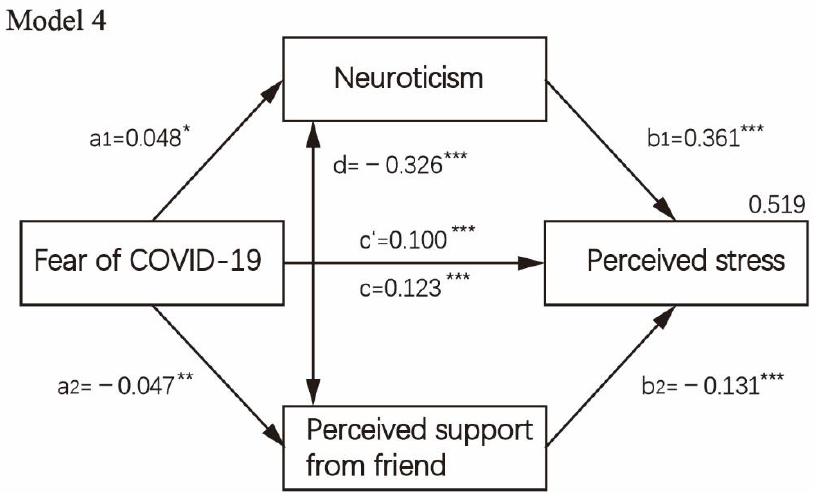
Figure 5. Mediation analysis test on fear of COVID-19 concerning perceived stress and mediating role of neuroticism and subscale of perceived social support from friends and controlling covariates, i.e., age, sex, education level, religion, occupation status, history of chronic non-communicable disease and quarantine status ( n = 3299). Note: * p < 0.05; ** p < 0.01; ***, p < 0.001.